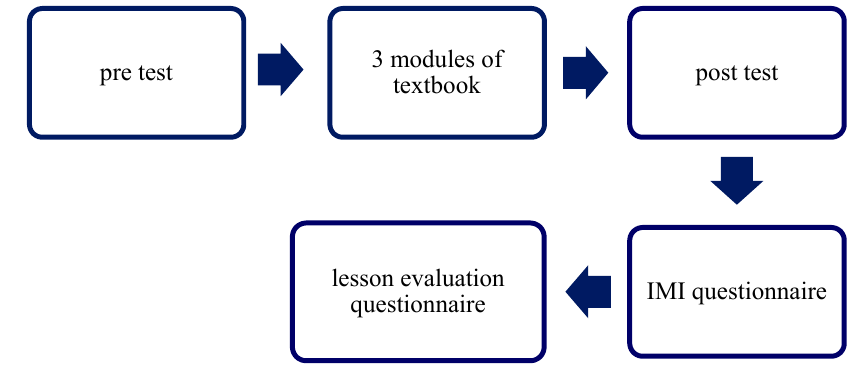
Figure 5. Control group’s process.